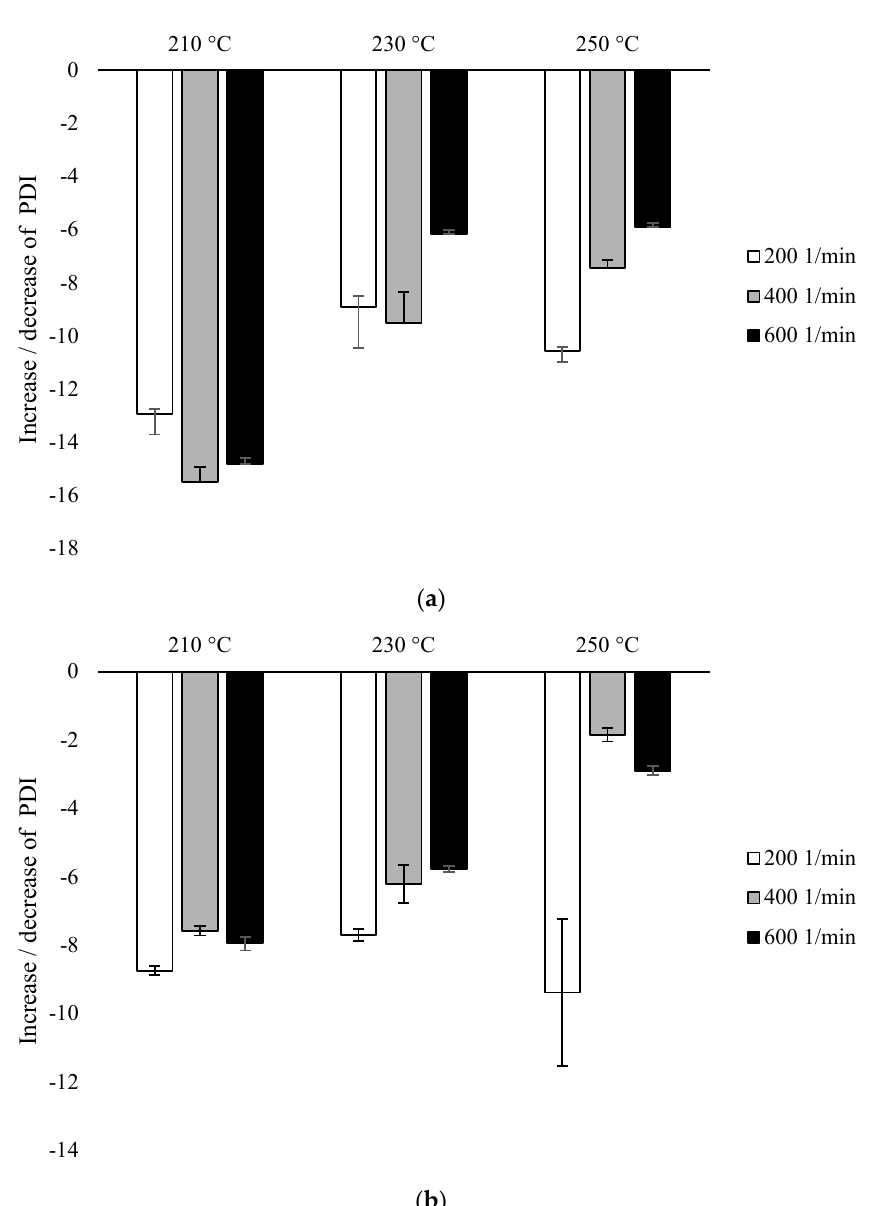
Figure 4. Polydispersity Index (PDI), % difference with untreated PLA: ( a ) configuration 1; ( b ) configuration of 2. Abbreviations: as in Table 1.